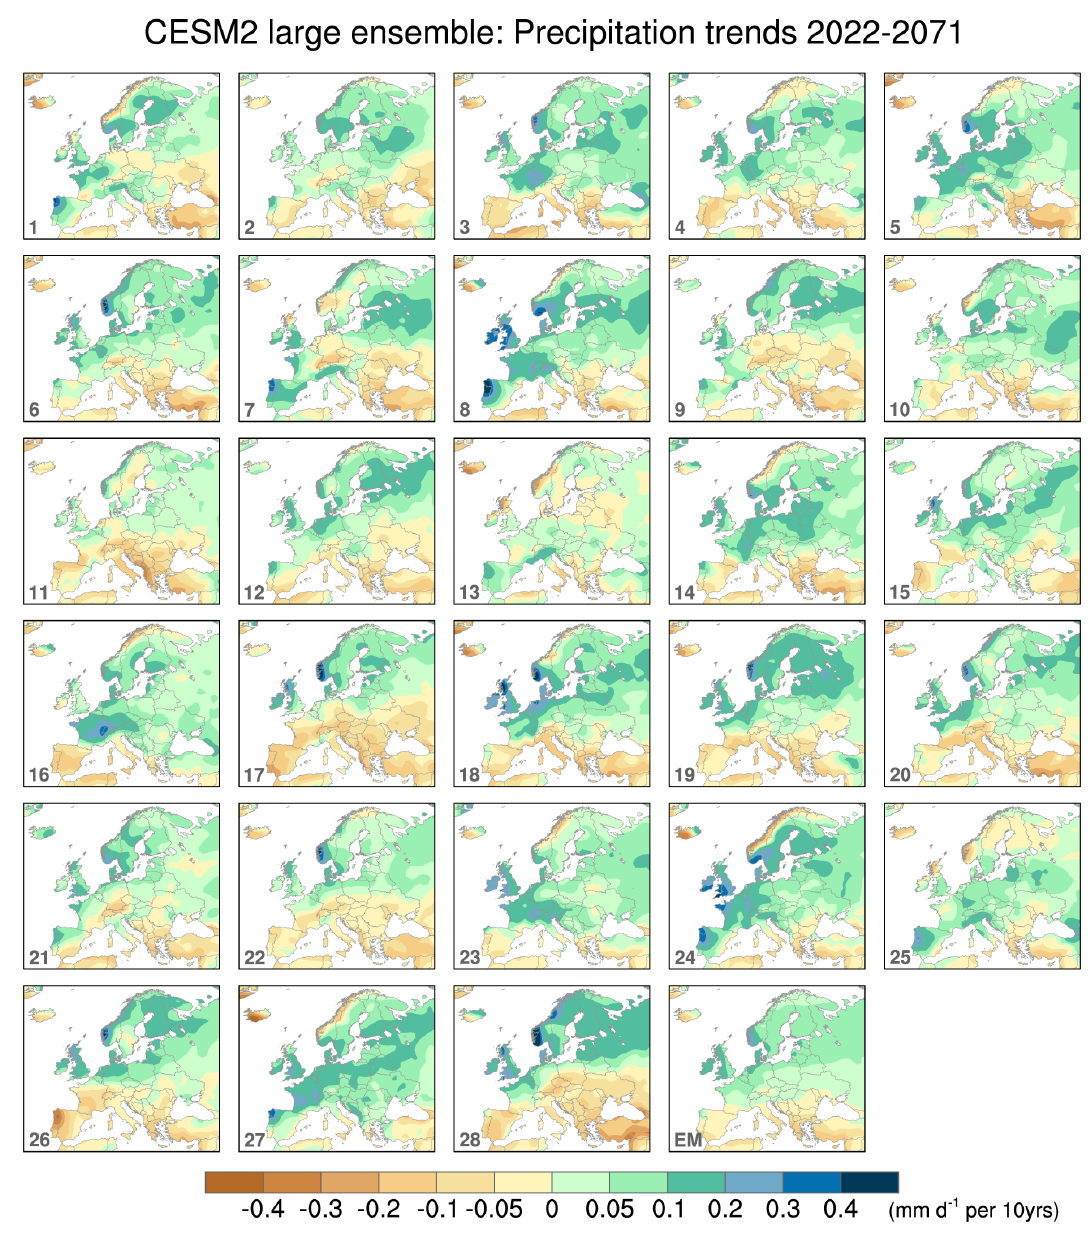
Figure 6. As in Fig. 2 but for the period